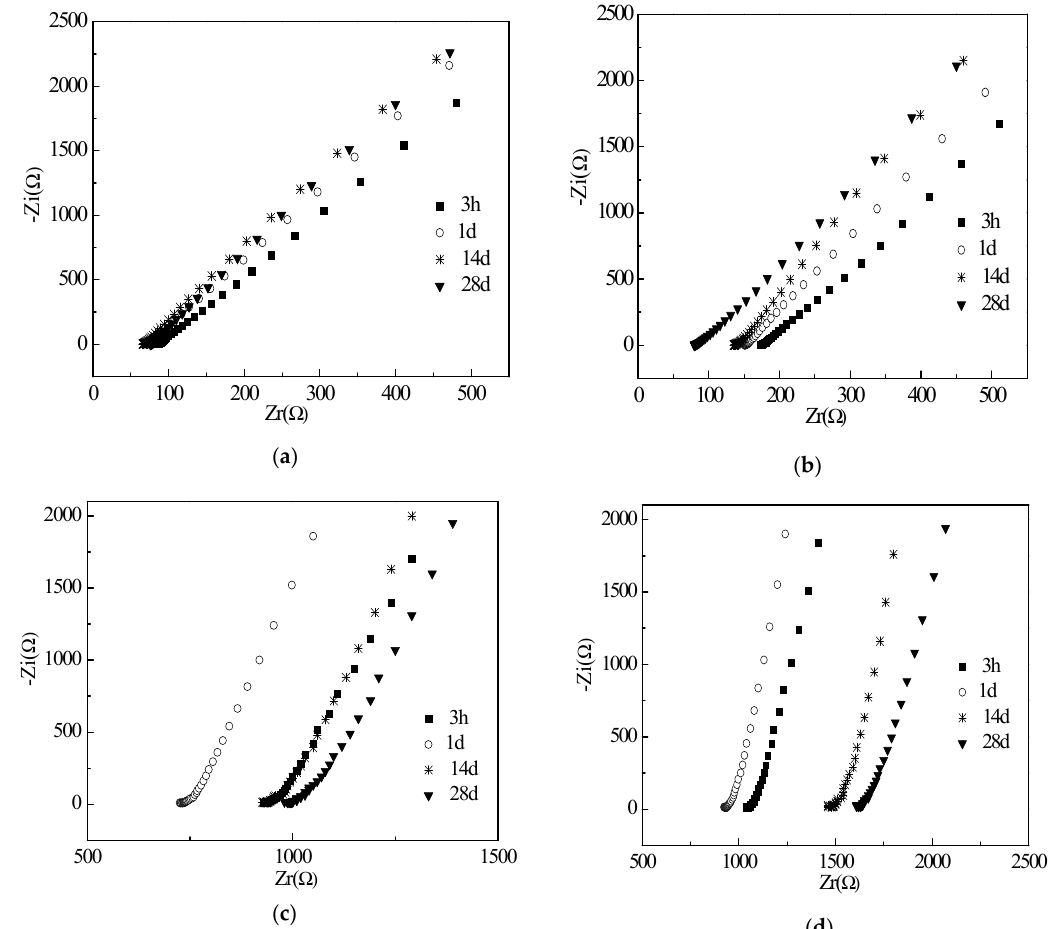
Figure 6. Electrochemical impedance spectroscopy (EIS) curves of specimens with w/c ratio of 0.40: ( a) RHA-1; ( b) RHA-2; ( c) RHA-3; ( d) RHA-4.